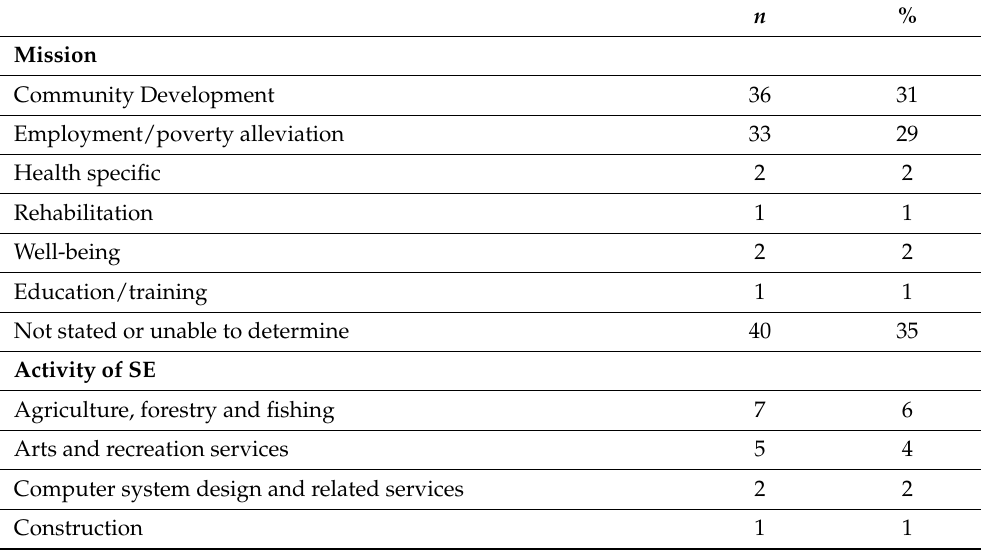
Table A1. Mission and activities of Indigenous social enterprises ( n = 115).